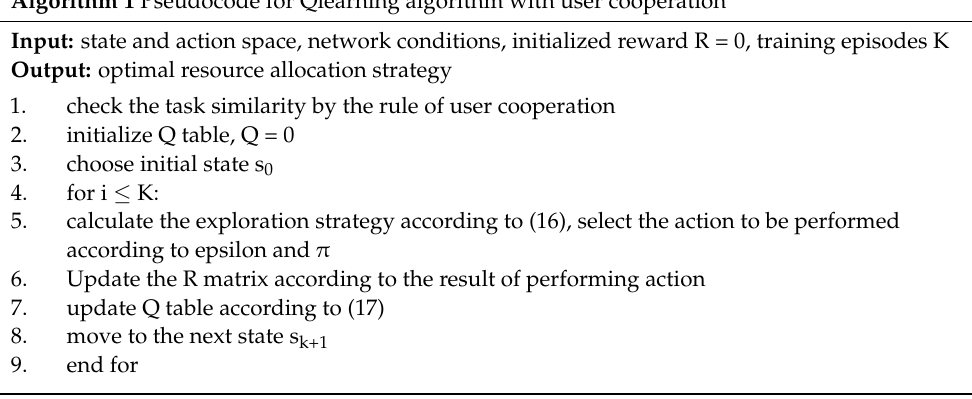
Algorithm 1 Pseudocode for Qlearning algorithm with user